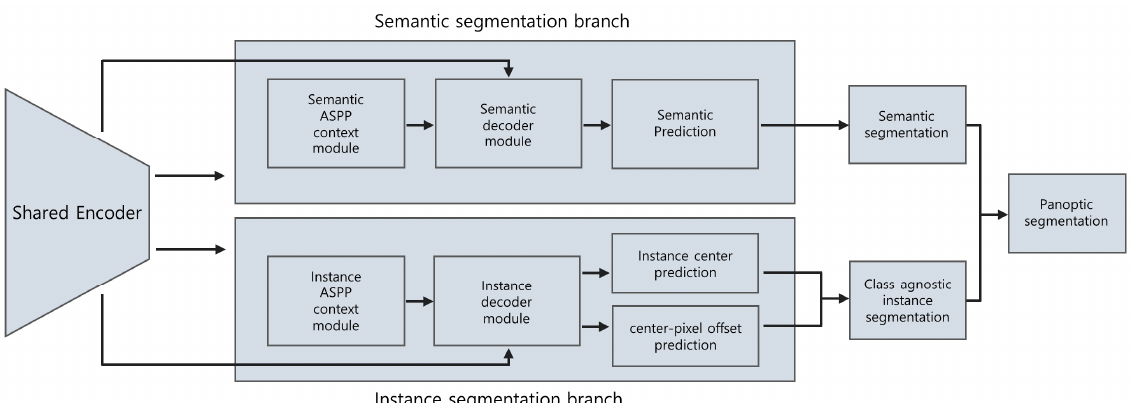
Figure 2. Overview of the model used in this study. Both semantic and instance segmentation branches use the same feature map and share the encoder. Each branch has its multiscale context module and decoder, both of which use ASPP. The instance segmentation branch predicts the center of mass for each instance and the offset vector between the center and each pixel. With the predicted center and the offset, the instance ID of each pixel can be determined, thereby resulting in class-agnostic instance segmentation. The final panoptic segmentation is obtained by fusing the results of the semantic segmentation and class-agnostic instance segmentation. ASPP, atrous spatial pyramid pooling.